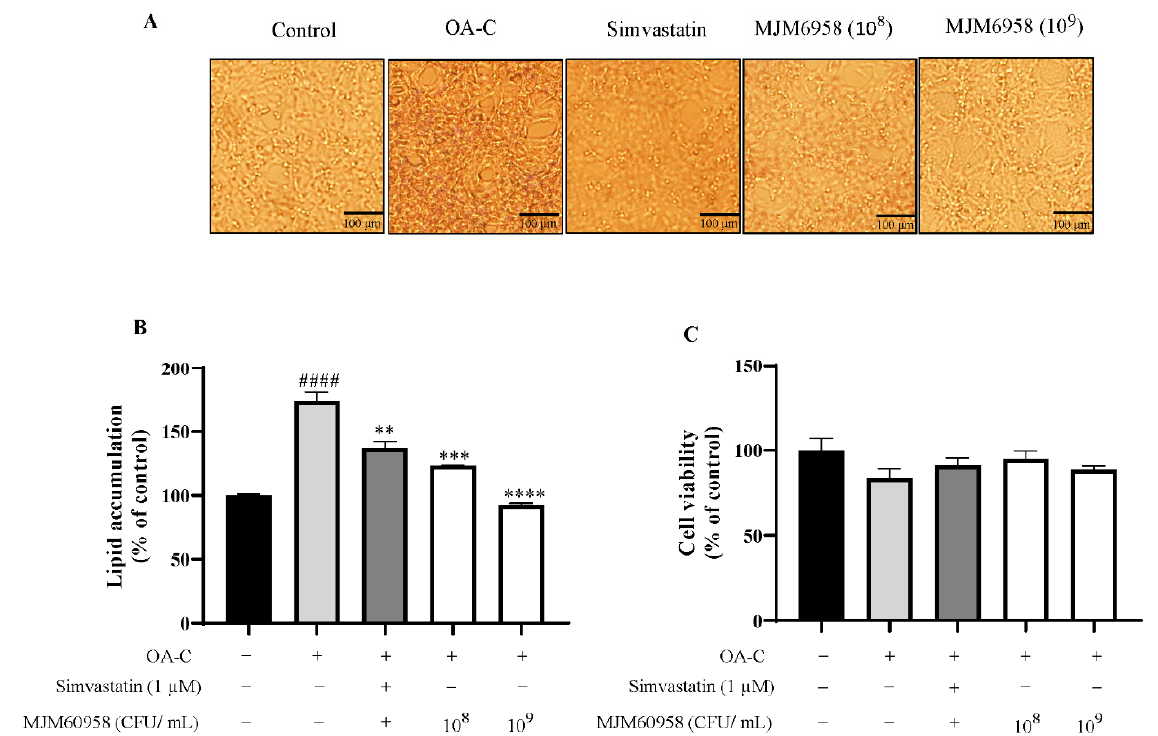
Figure 1. Effect of MJM60958 on HepG2 cells. ( A ) Typical image of Oil red O staining, scale bar: 100 µ m. ( B ) The effect of MJM60958 on the lipid accumulation of HepG2 cells. HepG2 cells were stimulated with 1 nM oleic acid and 7.5 µ g/mL cholesterol (OA-C) and treated with 10 8 and 10 9 CFUs/mL of MJM60958 for 6 h. Simvastatin (1 µ M) was used as a positive control. At the end of treatment, the cells were stained with Oil red O reagent and lipid accumulation was quantified by dissolving the stained fat droplet in isopropanol and measurement at 510 nm by an ELISA reader (TECAN Spectrofluor Plus, Maennedorf, Switzerland). ( C ) The effect of MJM60958 on the viability of HepG2 cells was measured using an MTT assay. Results are presented as the mean ± standard deviation of triplicate independent experiments. #### p < 0.01 compared with the control; ** p < 0.01, *** p < 0.001, **** p < 0.0001 compared with the OA-C treatment. Table 1. Assessment of ability to inhibit lipid accumulation on HepG2 cells of candidate strains. Lipid Accumulation Percent Reduction Samples (% of Control) (Compared with OA-C)